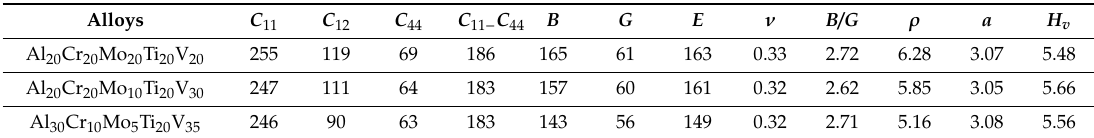
Table 2. Calculated three independent elastic constants (GPa); C 11 ; C 12 ; C 44 , Cauchy pressure C 11 − C 44 (GPa), bulk modulus B (GPa), shear modulus G (GPa), Young’s modulus E (GPa), Poisson’s ratio ( ν ), Pugh’s ratio ( B / G ), lattice constant a (Å), density ρ (gm / cm 3 ) and hardness H v (GPa) at zero pressure and Kelvin, respectively.